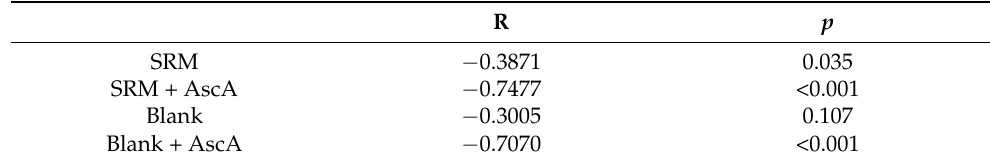
Table 1. Pearson’s correlation coefficient between free thiol groups concentration and GSNO decom- position measured in neat blood plasma samples (blank) or supplemented with particulate matter’s extract (SRM) or/and ascorbic acid (AscA). The values of p < 0.05 were considered significant. R p SRM − 0.3871 0.035 SRM + AscA − 0.7477 <0.001 Blank − 0.3005 0.107 Blank + AscA − 0.7070